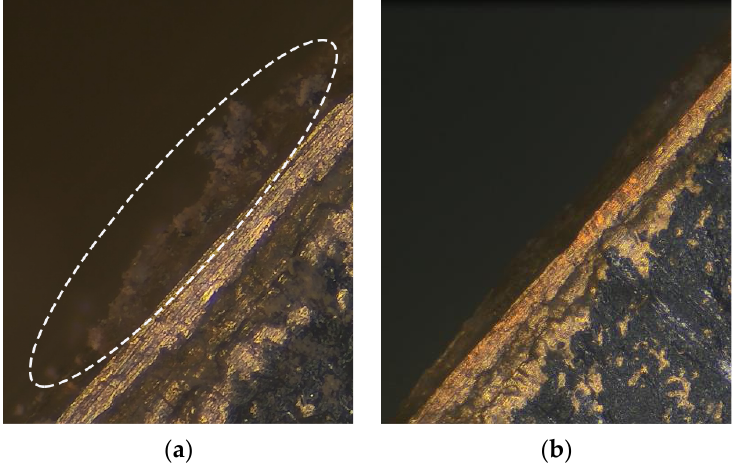
Figure 13. Contrasting distribution of dust particles on the left side of the vibrator: ( a ) Before vibration; ( b ) After vibration.